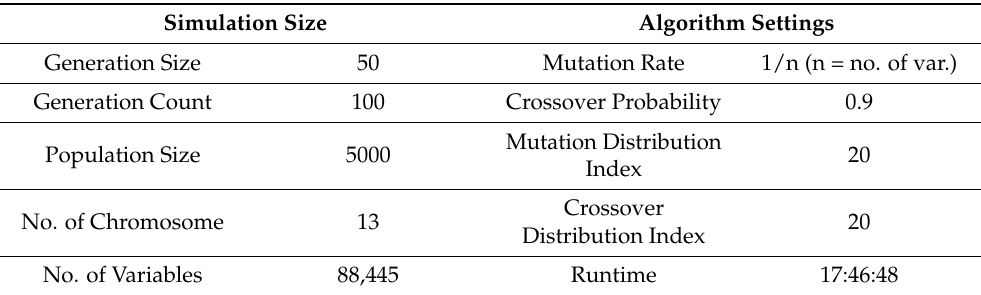
Table 1. Simulation and algorithm settings.